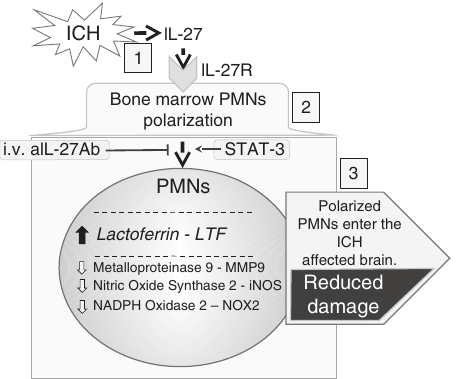
Fig. 7 In response to injury caused by ICH, activated brain microglia and spleen rapidly produce IL-27 ( 1 ), a cytokine, which modi fi es the developing PMNs in the BM to express more of a potent iron-sequestrating LTF and less of pro-in fl ammatory factors ( 2 ). This process is referred to as PMNs polarization. In consequence, these polarized PMNs may carry more cytoprotective LTF. Upon entering the injured brain, the PMNs may release more LTF that through sequestrating the cell-free ferric iron (produced due to intra-hematoma hemolysis) alleviates oxidative stress,